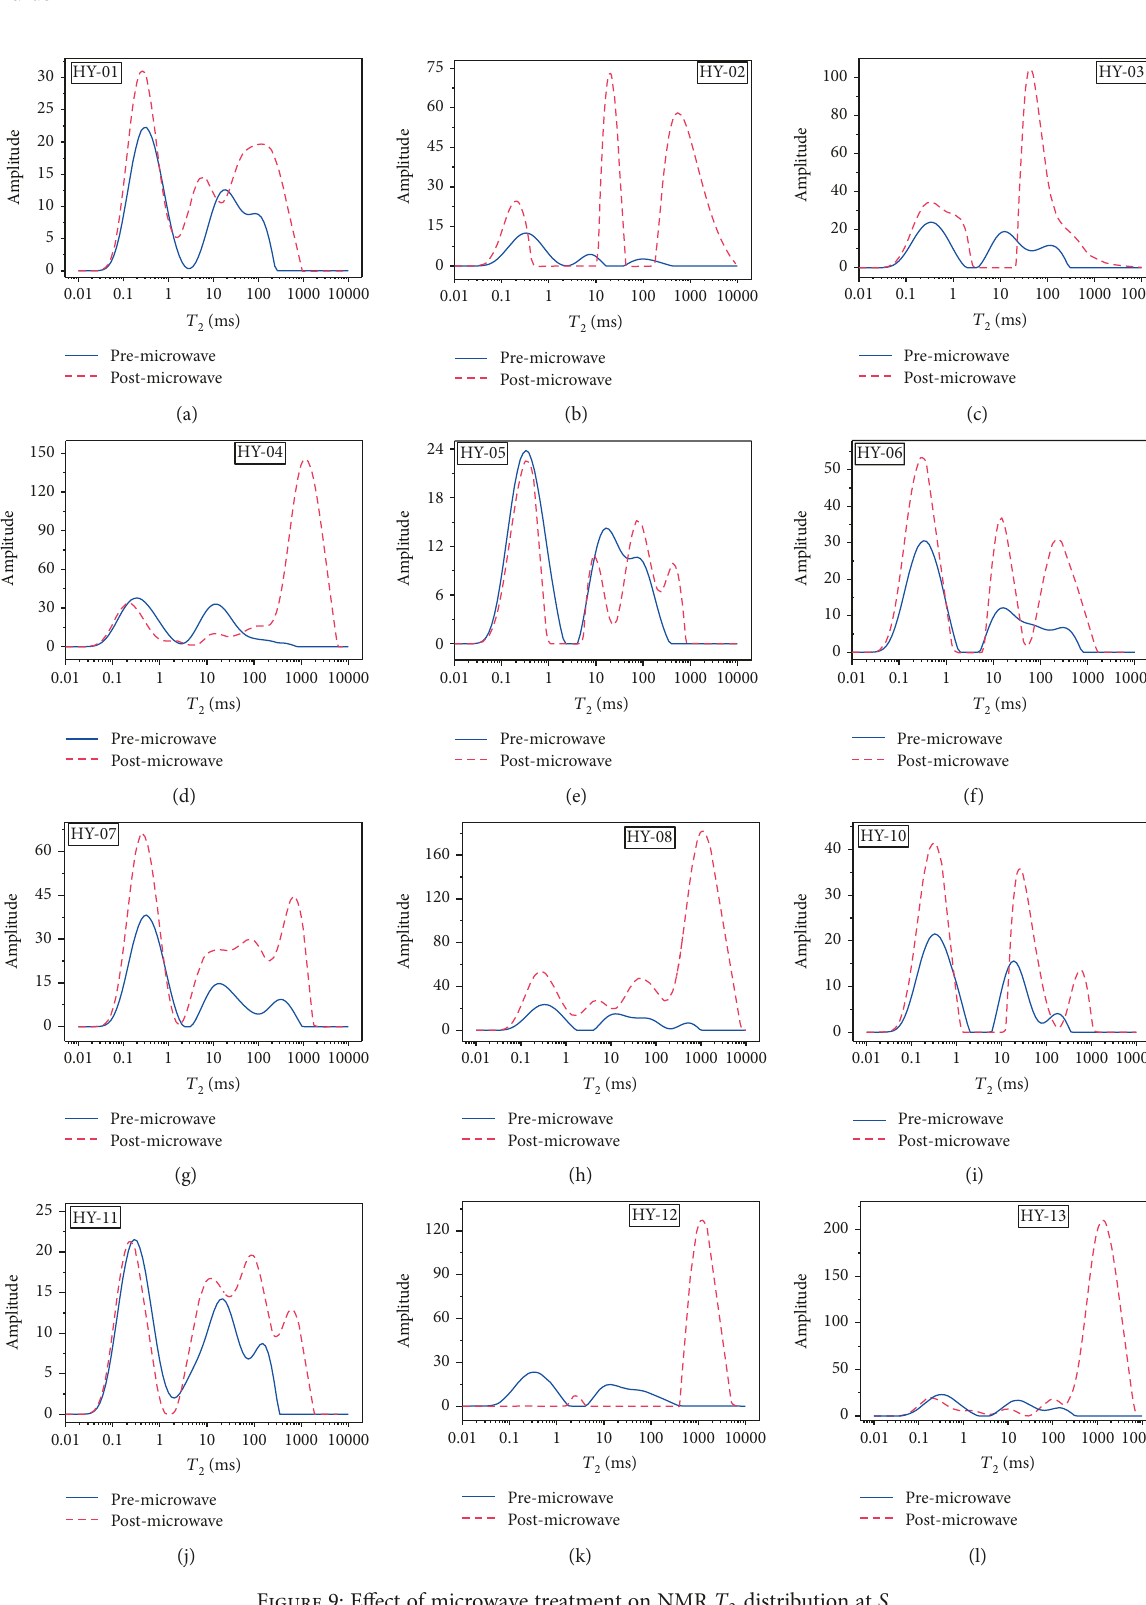
Figure 9: E ff ect of microwave treatment on NMR T